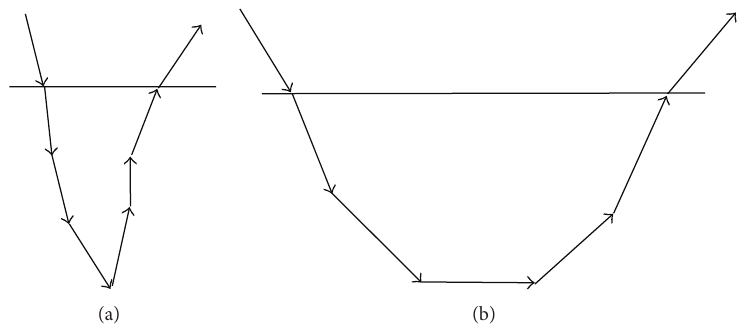
Figure 2: Paths with backward scattering (a) and “tilted” forward scatterings (b).